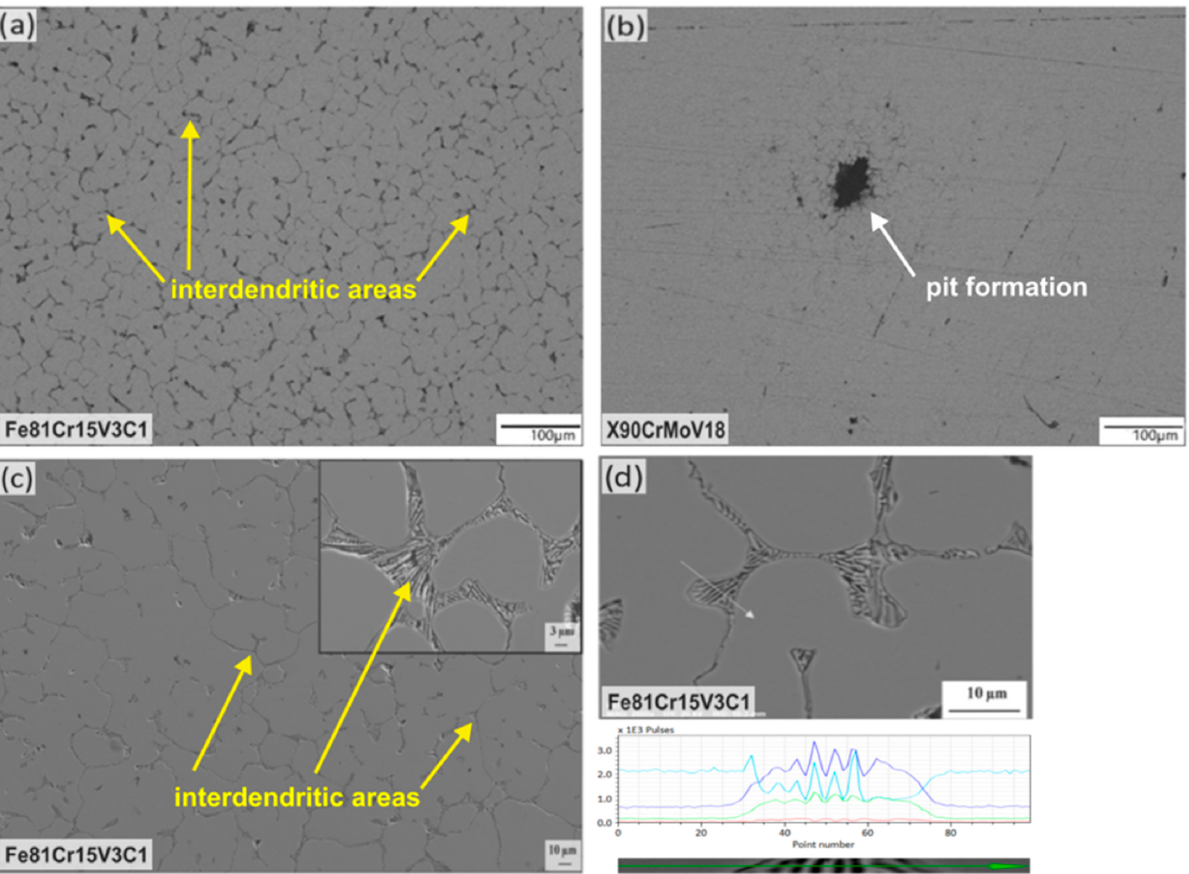
Figure 9. Optical micrographs of the surface morphologies of the novel cast steel Fe81Cr15V3C1 ( a ) and the reference steel X90CrMoV18 ( b ) after immersion in 3.5 wt% NaCl solution for 24 h. SEM micrographs of the surface of the novel cast steel Fe81Cr15V3C1 after immersion for 72 h ( c ) with corresponding EDX line scan (see arrow): Fe—blue, Cr—indigo, V—green and C—red ( d ).